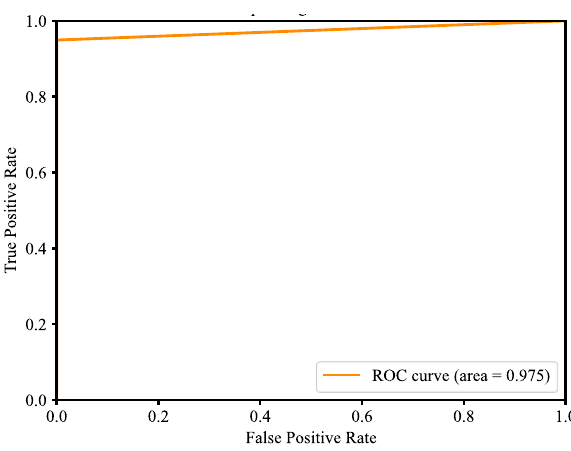
Figure 34. ROC curve of mask wearing detection.